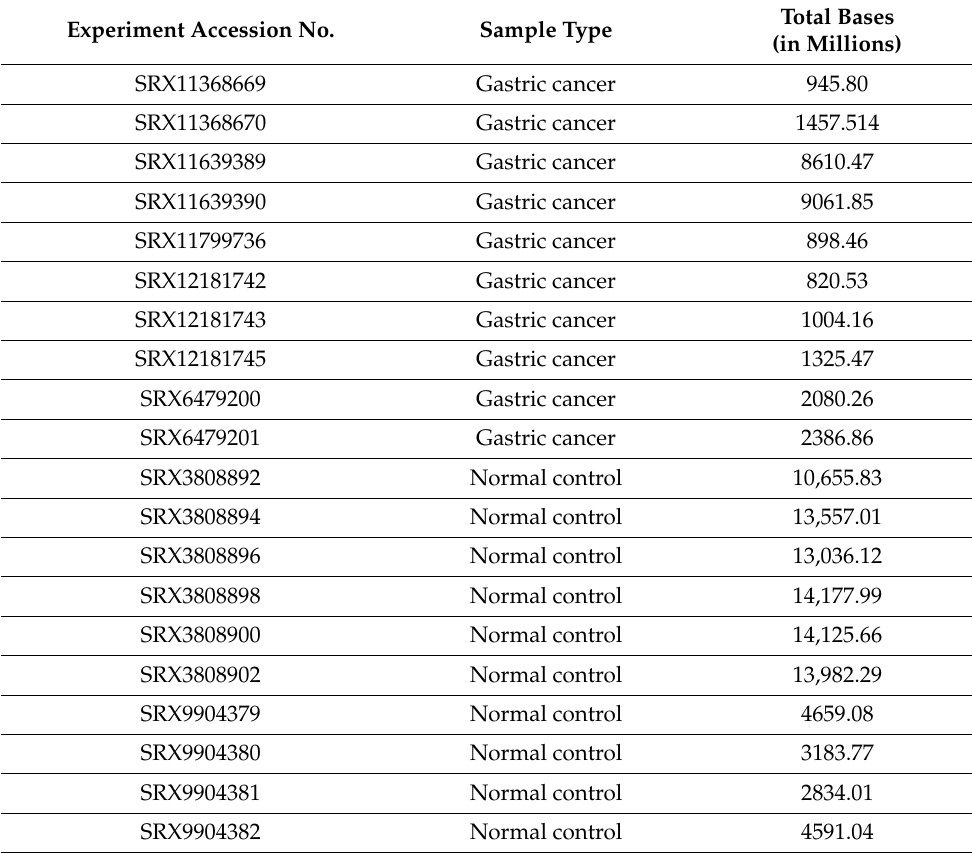
Table 1. RNA-seq datasets (gastric cancer and normal tissue